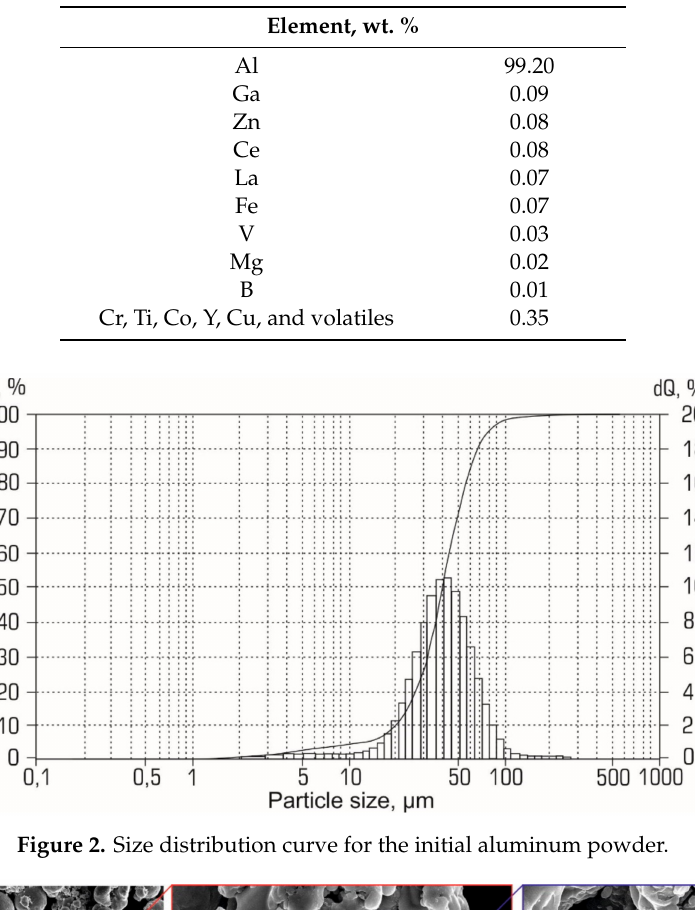
Table 2. Parameters of obtaining aluminum-alumina powdery composites.